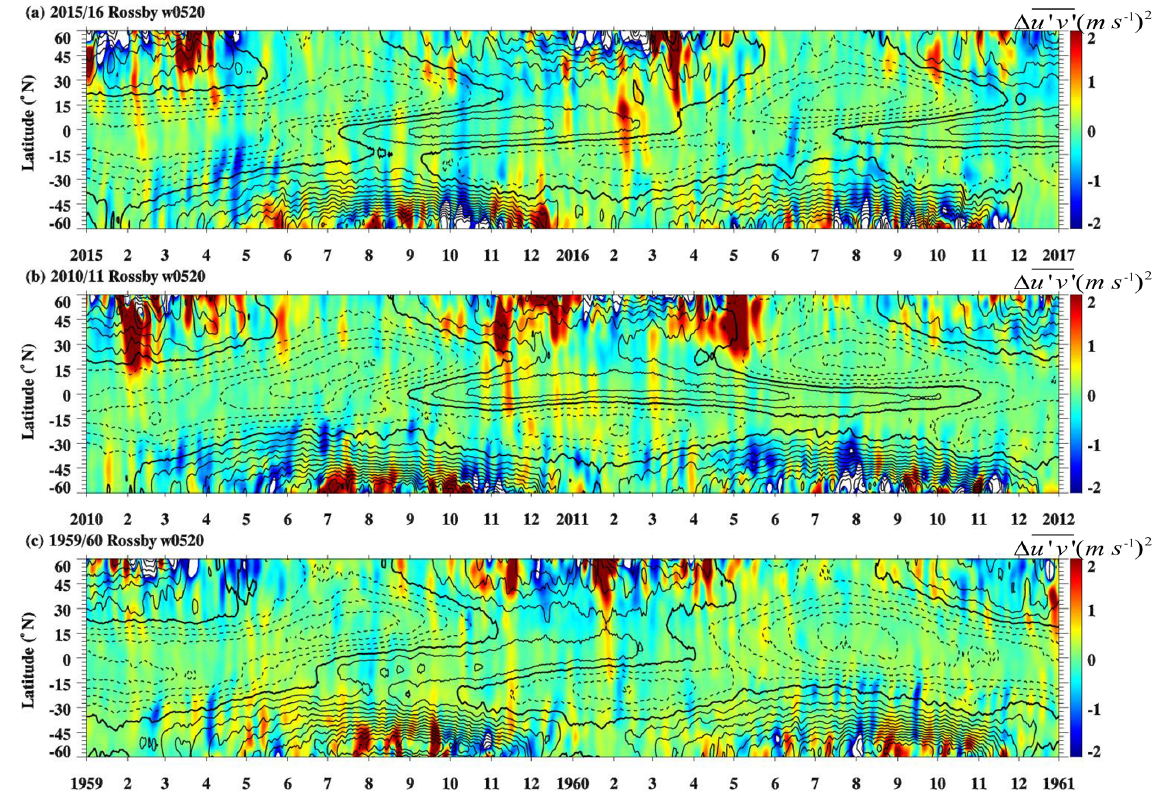
Figure 9. The time–latitude cross section of the Rossby waves (with periods of 5–20d) in (a) 2015/2016, (b) 2010/2011, and (c) 1959/1960 at 40hPa. Color shadings denote the anomalies with respect to the monthly climatology (0m 2 s − 2 ). The zonal mean zonal wind is overlaid in black contours with contour interval of 5ms − 1 . The solid and dotted black contours denote westerly and easterly winds, respectively. The thick contours represent the zero wind